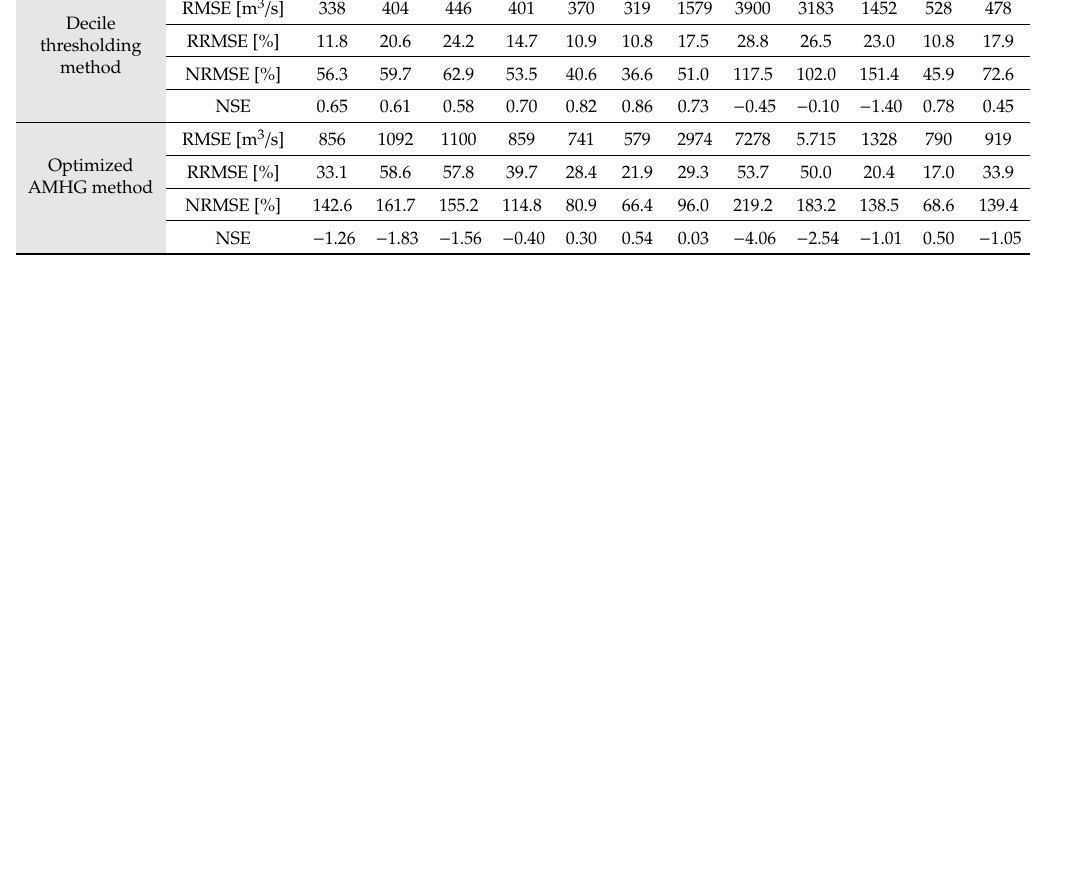
normalized root mean square error (NRMSE), and Nash–Sutcli ff e e ffi ciency (NSE) for the decile